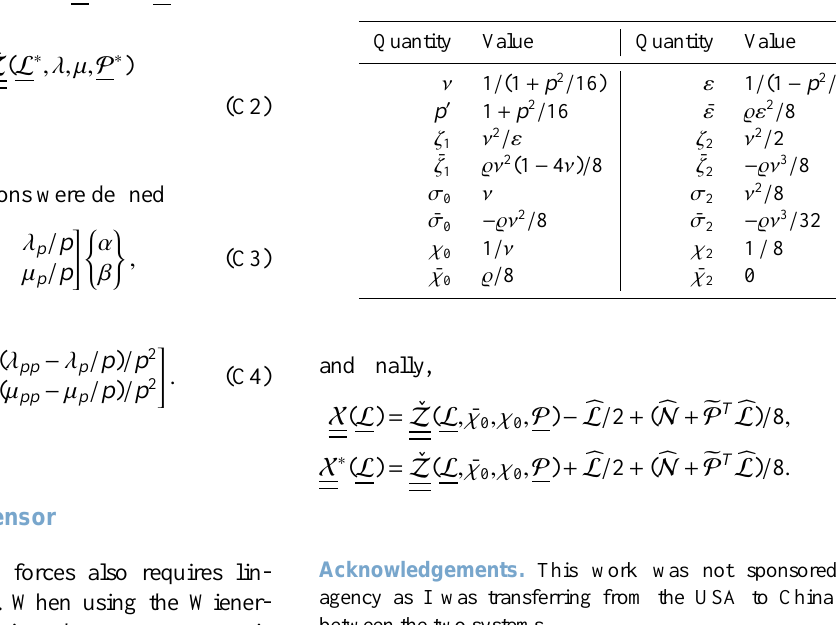
Table D1. Scalars functions associated with the Wiener-Milenkovi´c motion